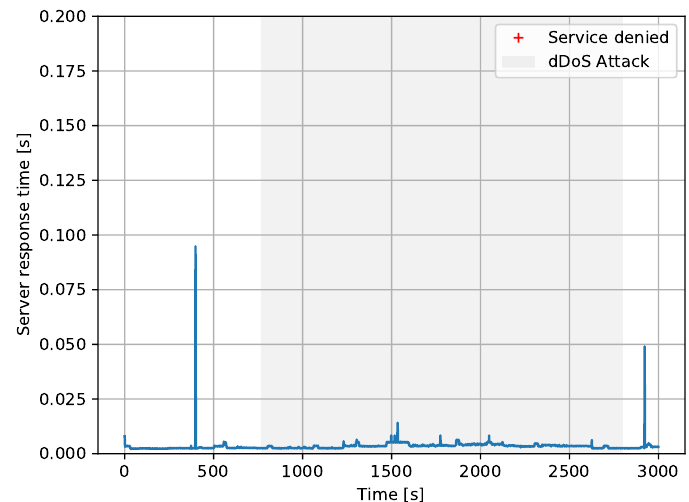
Figure 9. Autopolicy enabled. Grey area shows when the attack took place. Blue line shows the response time as seen from the user to the Service